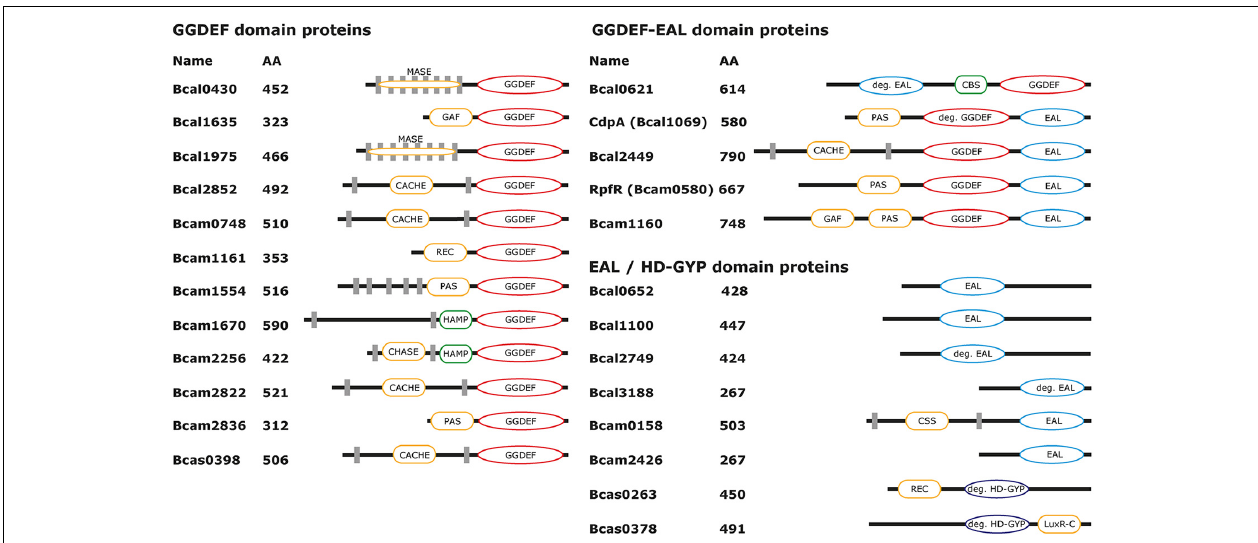
FIGURE 1 | Domain structure of GGDEF/EAL/HD-GYP proteins of B. cenocepacia H111. Proteins were identified by comparative BLAST analysis of well described GGDEF-, EAL- and HDY-GYP domains from E. coli and X. campestris (see text for details). Protein sequences were analyzed with Pfam and NCBI-CDD web tools. Transmembrane domains (gray squares) were verified with the TMHMM web tool. GGDEF domains are highlighted in red, EAL domains in blue and HD-GYP domains in violet, sensor domains in yellow or green. If a protein name has been assigned, it is also shown here.